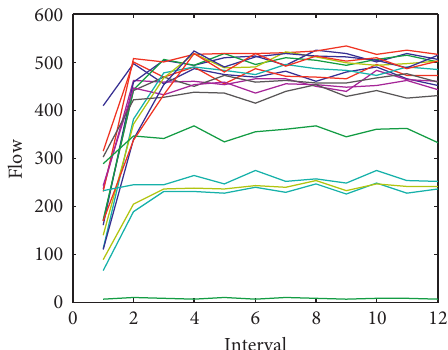
Figure 9: Two-dimensional density with VSL.